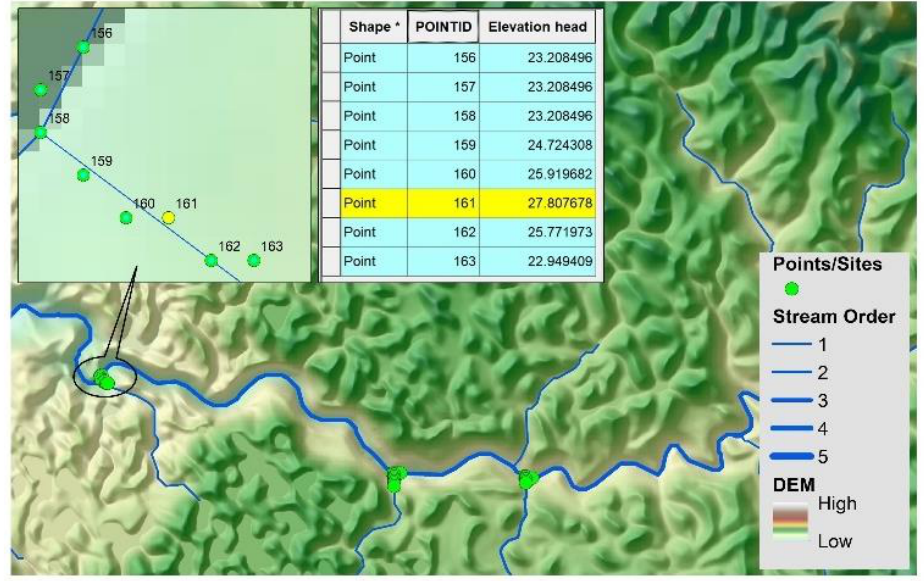
Figure 3. Points clustering on river segments. The selection of a representative point considers the location and the elevation value.